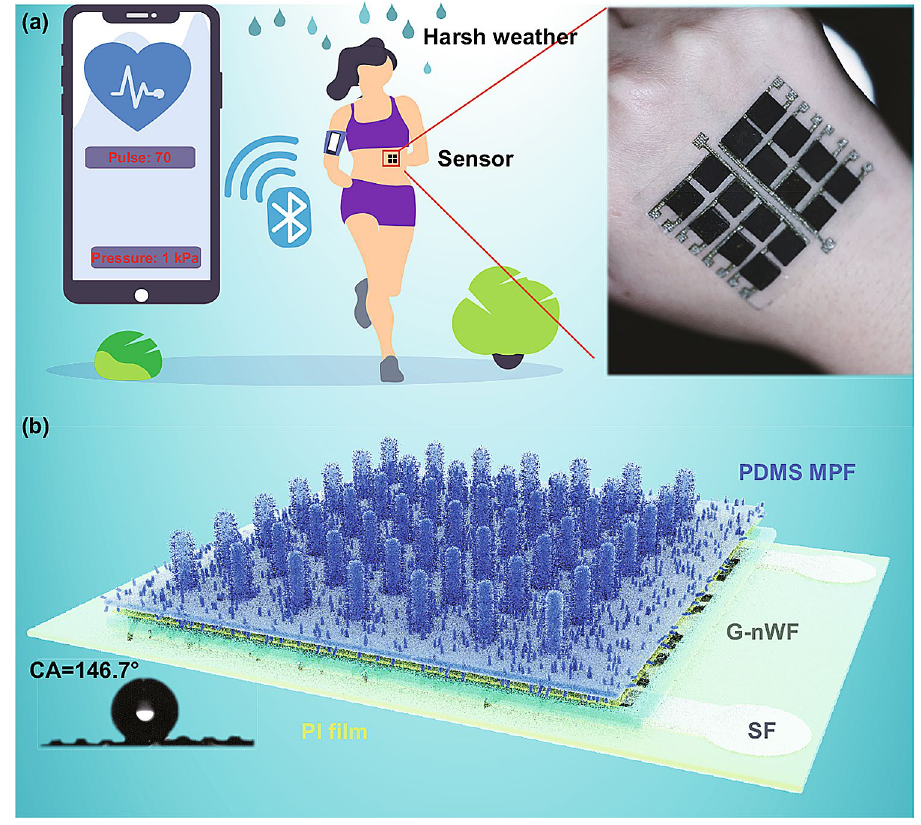
Fig. 1 Schematic illustration of the flexible sensor. a Wearable sensor capable of successfully monitoring the pulse rate and sending the signal to the smartphone via the Bluetooth and the digital optical images of the waterproof sensor mounted onto our hand. b Schematic illustration of the structure of the sensor and its waterproof